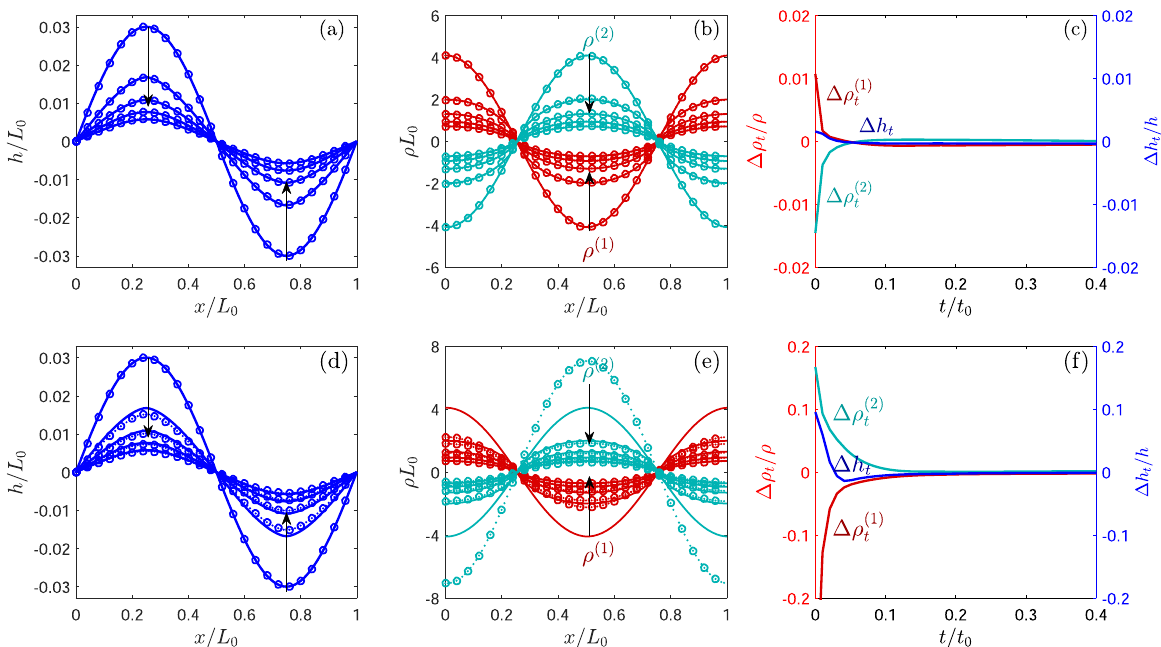
Fig. 4 Comparison of the reduced-order model and the full multi-disconnection mode model. The temporal evolution of the GB pro fi le in a , d and density in b , e of each disconnection mode using the reduced-order model (solid lines) and the full multi-disconnection mode model (dashed lines with circles) for two-disconnection modes. The arrows indicate the direction of the evolving curves. c , f The difference between the predictions of the reduced-order model and the full multi-disconnection mode model for the GB velocity and rates of change of the disconnection densities during the evolution of the initially sinusoidal pro fi le GB. These data are calculated at the positions of the arrows in a , b , d and e . Panels a – c correspond to the case where the initial disconnection densities in both models are the same (19), and d – f correspond to a case where the initial densities are different — as described in the